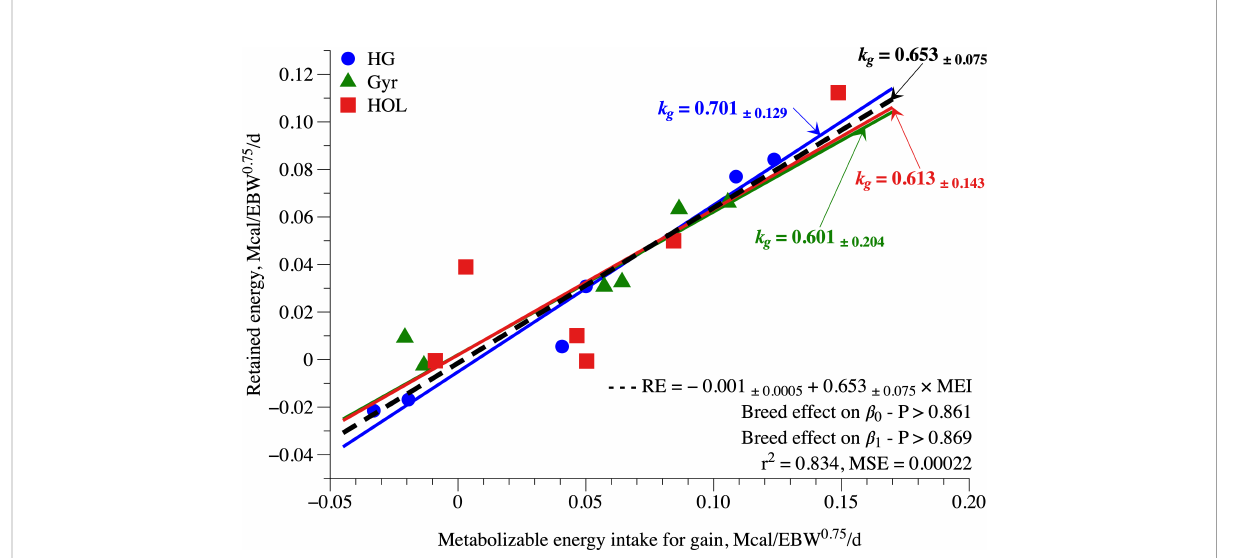
FIGURE 3 Ef fi ciency of use of metabolizable energy for gain ( k g ) of Holstein, Gyr, and Holstein × Gyr dairy heifers fed at three feeding levels (FL). The blue, green, and red dashed lines represent the regressions for HG, Gyr, and Holstein, respectively. The black dashed line represents the general trend without breed